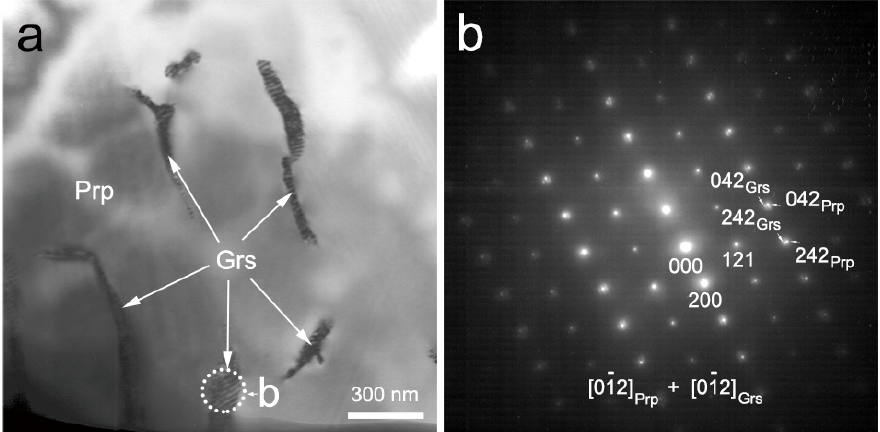
Figure 5. TEM images of Grs-rich exsolutions precipitated at the dislocations of Prp-rich host. ( a ) Grs-rich exsolutions precipitated at the dislocations of Prp-rich host. ( b ) SAED pattern obtained from the area marked in ( a ) shows the exsolution bearing the same crystallographic orientation with host.